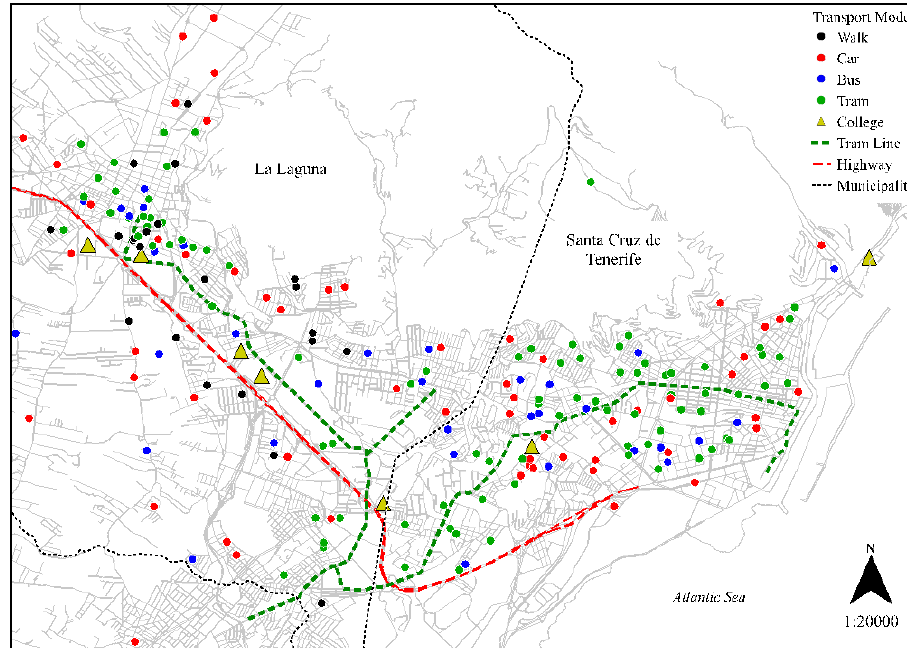
Figure 2. Stated Preferences before tram implementation (2007)